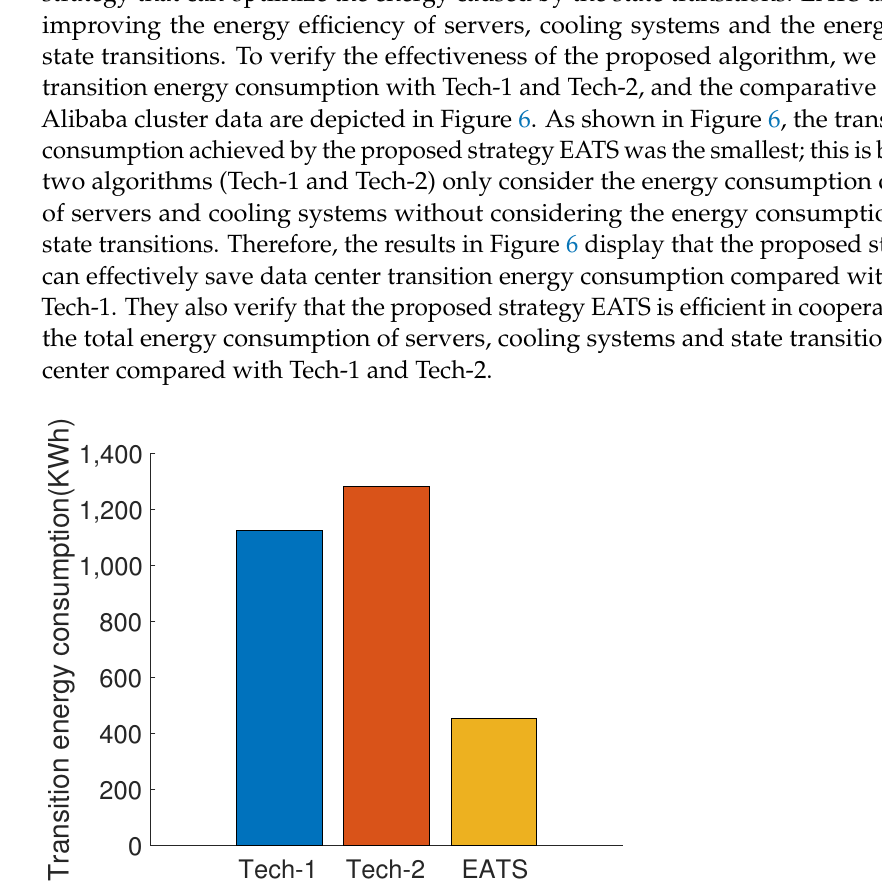
Figure 6. The comparison results of transition energy consumption for Alibaba cluster